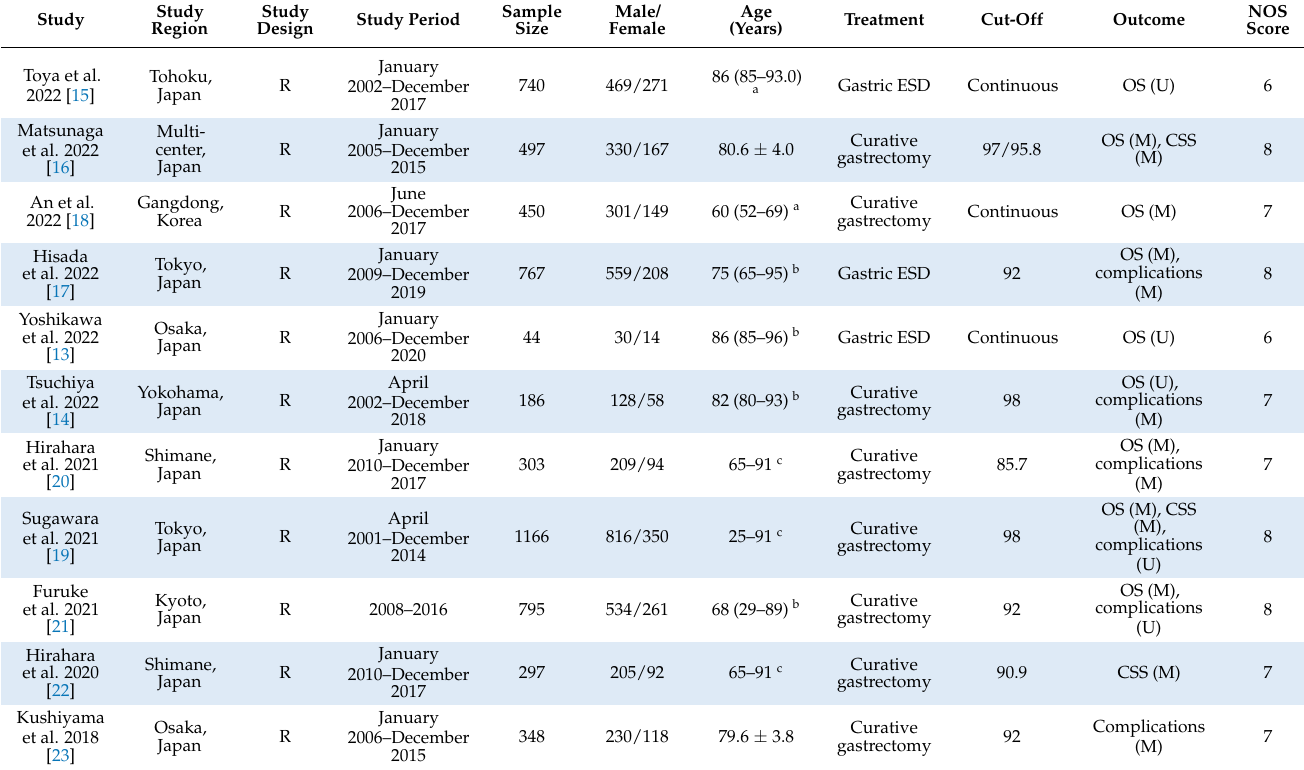
Table 1. Main characteristics of the studies